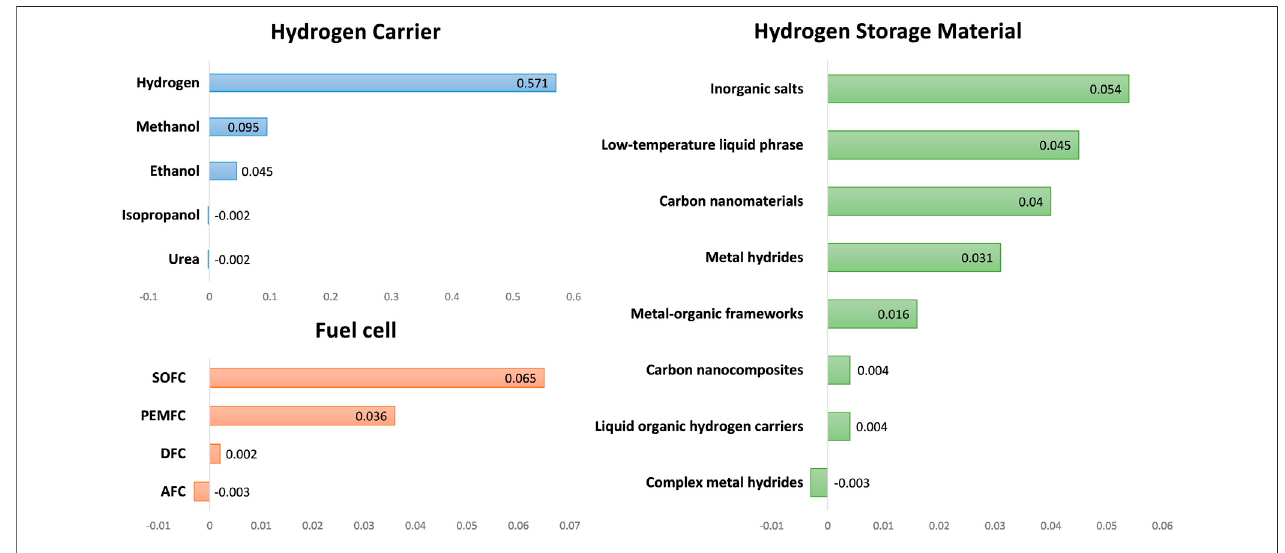
FIGURE 12 | Utility values of technological